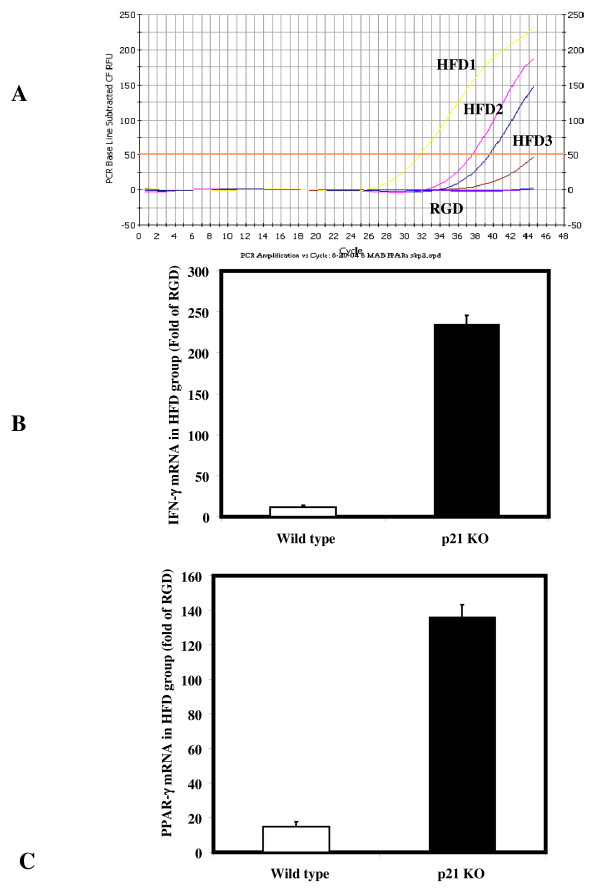
Quantitative mRNA expression of IFN-γ, PPAR-γ and NADPH oxidase components (p22phox, NOX-1 and Rac-1) in aortic tissues from p21-/- mice. Amplification curves for IFN-g in RNA isolated from aorta from mice fed with high fat diet (HFD) and regular diet (RGD) are shown. Significantly higher Relative fold expression of IFN-γ (B), PPAR-γ (B) mRNA is shown in Wild type (open bars) and p21-/- mice (closed bars). The values are means ± SEM of fold increase in high fat diet compared to the results obtained from mice fed with regular diet.